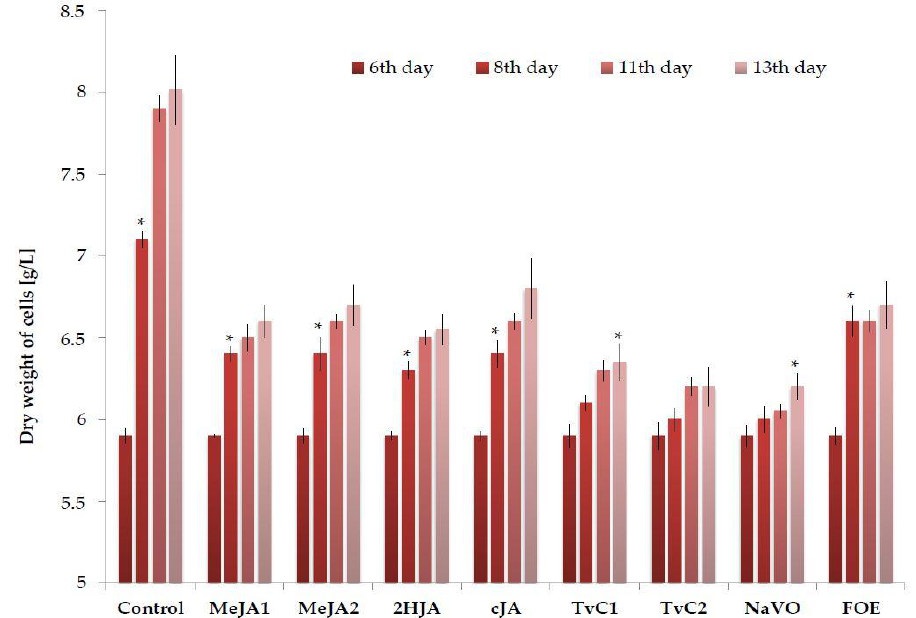
Figure 1. Changes in dry weight of control and elicited grapevine cells during cultivation in vitro on the 6th, 8th, 11th, and 13th day of cultivation (*—statistical significance, p ≤ 0.05).